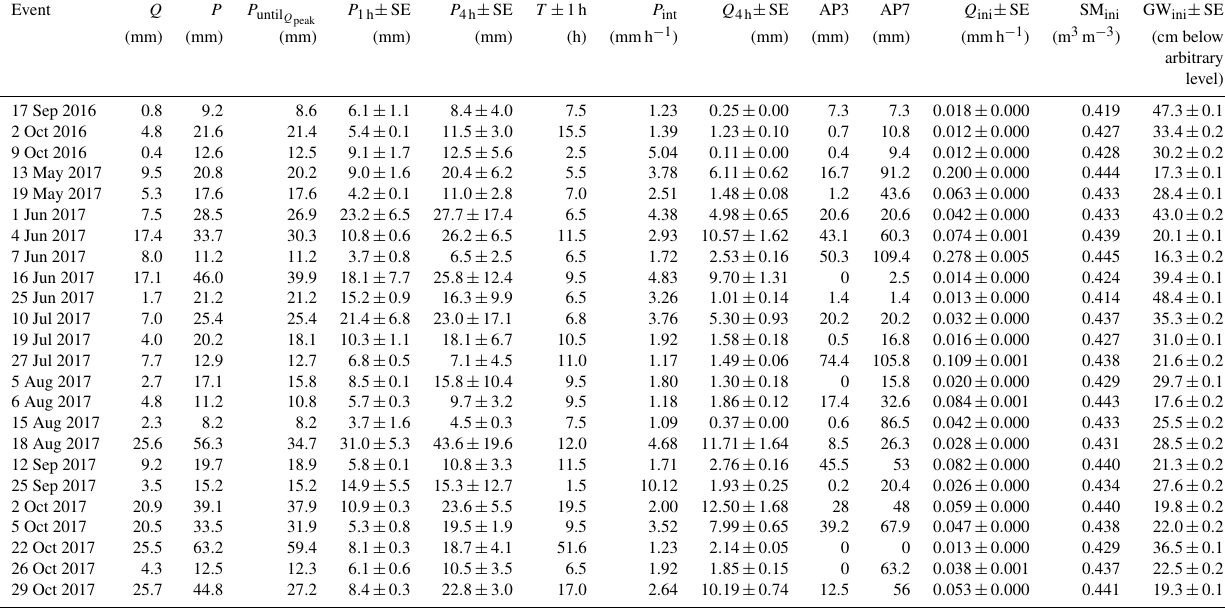
Table 1. Properties of the storm events: total discharge ( Q ), total precipitation ( P ), cumulative precipitation before peak flow ( P untilQpeak ), mean precipitation intensity ( P int ), maximum precipitation over 1h ( P 1h ) and 4h ( P 4h ), event duration ( T ), and 4h peak discharge volume ( Q 4h ). The initial catchment wetness state was quantified using 3-day and 7-day antecedent precipitation (AP3 and AP7) as well as the 1h average values of discharge ( Q ini ), groundwater table depth (GW ini ) and soil moisture (SM ini ) before the onset of the storm event. Event